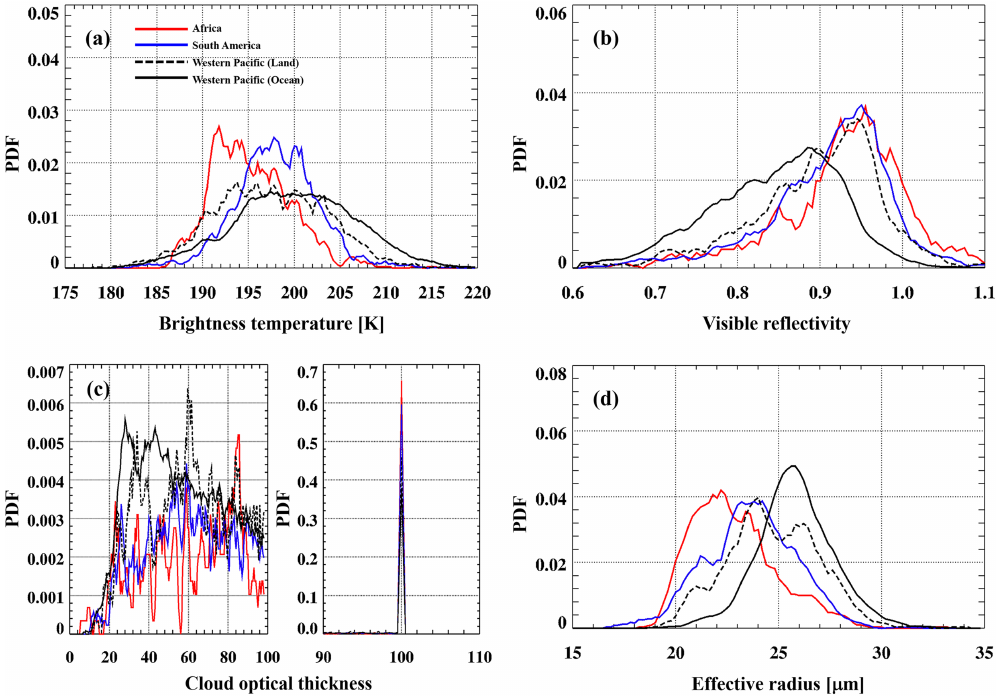
Figure 2. Distributions of PDFs of (a) brightness temperature at 11µm, (b) reflectivity at 0.645µm, and (c) cloud optical thickness; (d) ef- fective radius from MODIS products. All data are from MODIS measurements and associated products. The red, blue, yellow, and black solid lines represent DCCs observed over African, South American, WP-land, and WP-ocean domains,